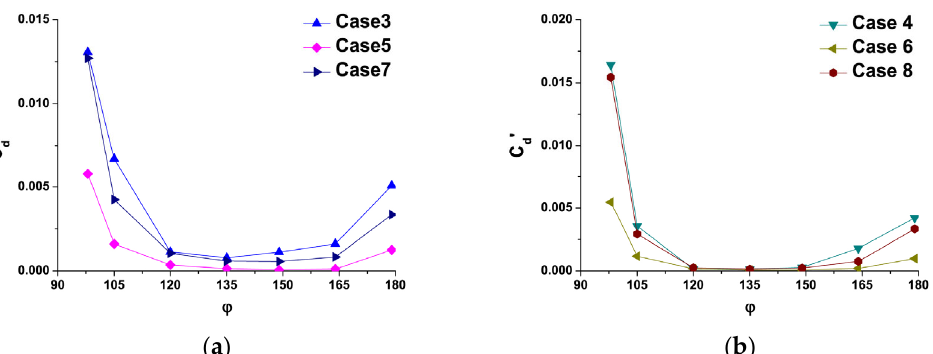
Figure 18. The local time-averaged drag coefficients along the curved channel after the confluence: ( a ) Cases with tributary discharge ratio 𝜆 (cid:3404) 0.3 ; ( b ) Cases with tributary discharge ratio 𝜆 (cid:3404) 0.6 .